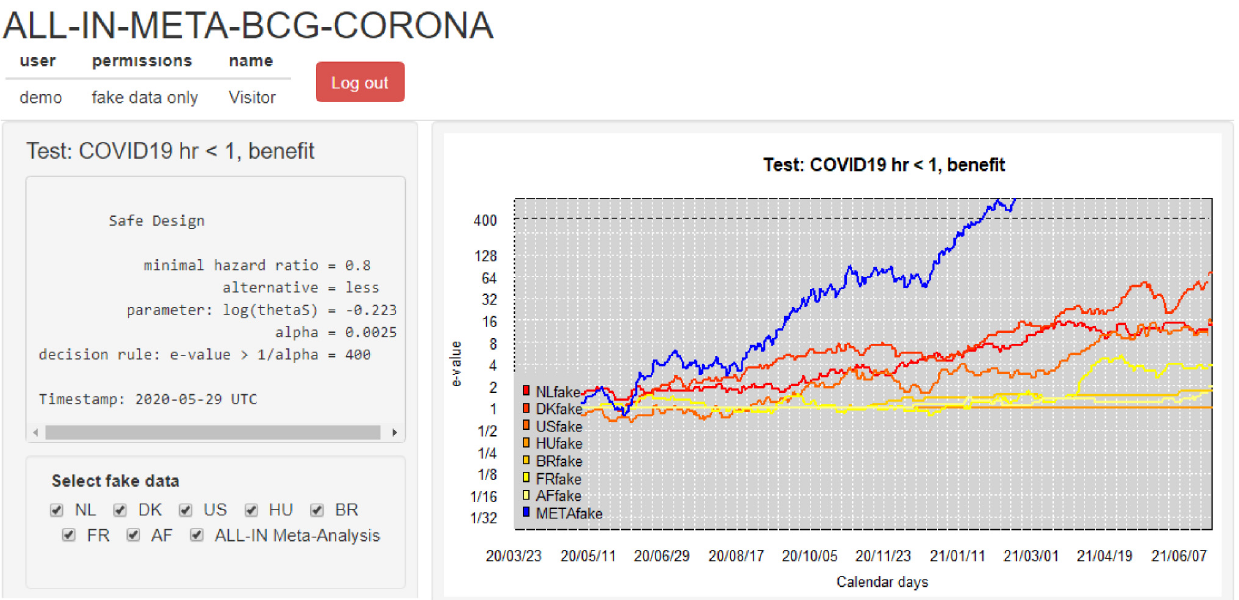
Figure 6. Dashboard used to communicate interim results in ALL-IN-META-BCG-CORONA to all data uploaders with a login. The involved trials were performed in the Netherlands (NL), Denmark (DK), the United States (US), Hungary (HU), Brazil (BR), France (FR) and Guinea-Bissau/Mozambique (AF). The dashboard is in demo mode and shows synthetic (“fake”) data. The option to (de)select trials is for plotting purposes of individual trial e -values; all trials in the dashboard stay included in the meta e -value, following the decision from the Steering committee on trial inclusion. Note that the y-axis is on the log